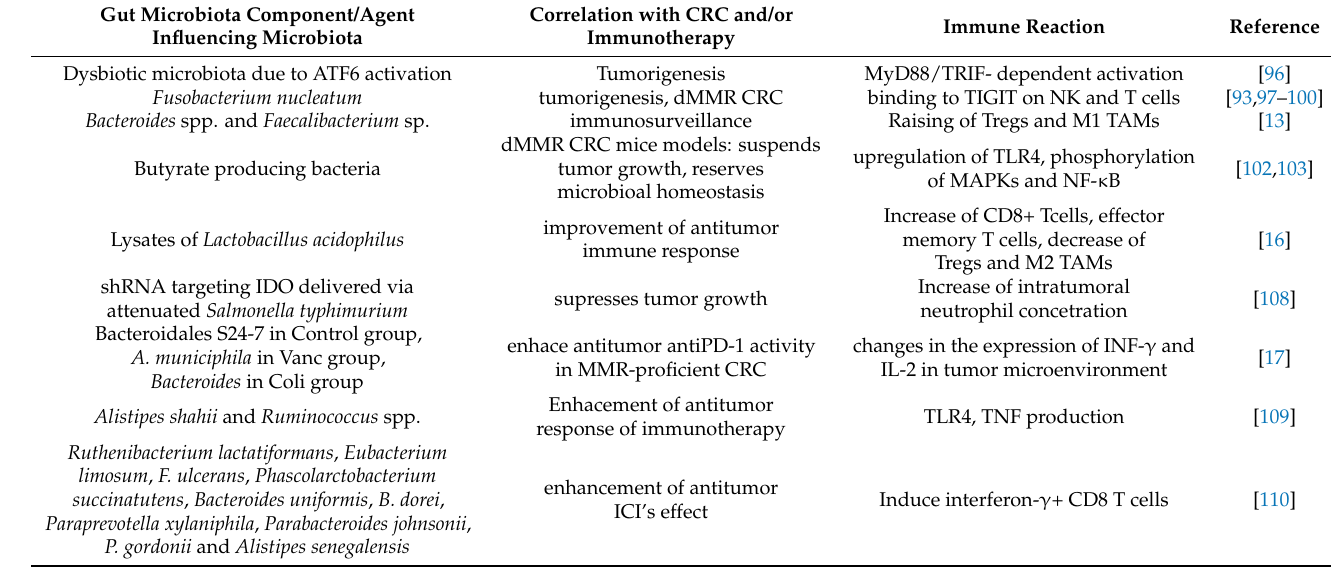
Table 2. Interference of gut microbiota with immune response in